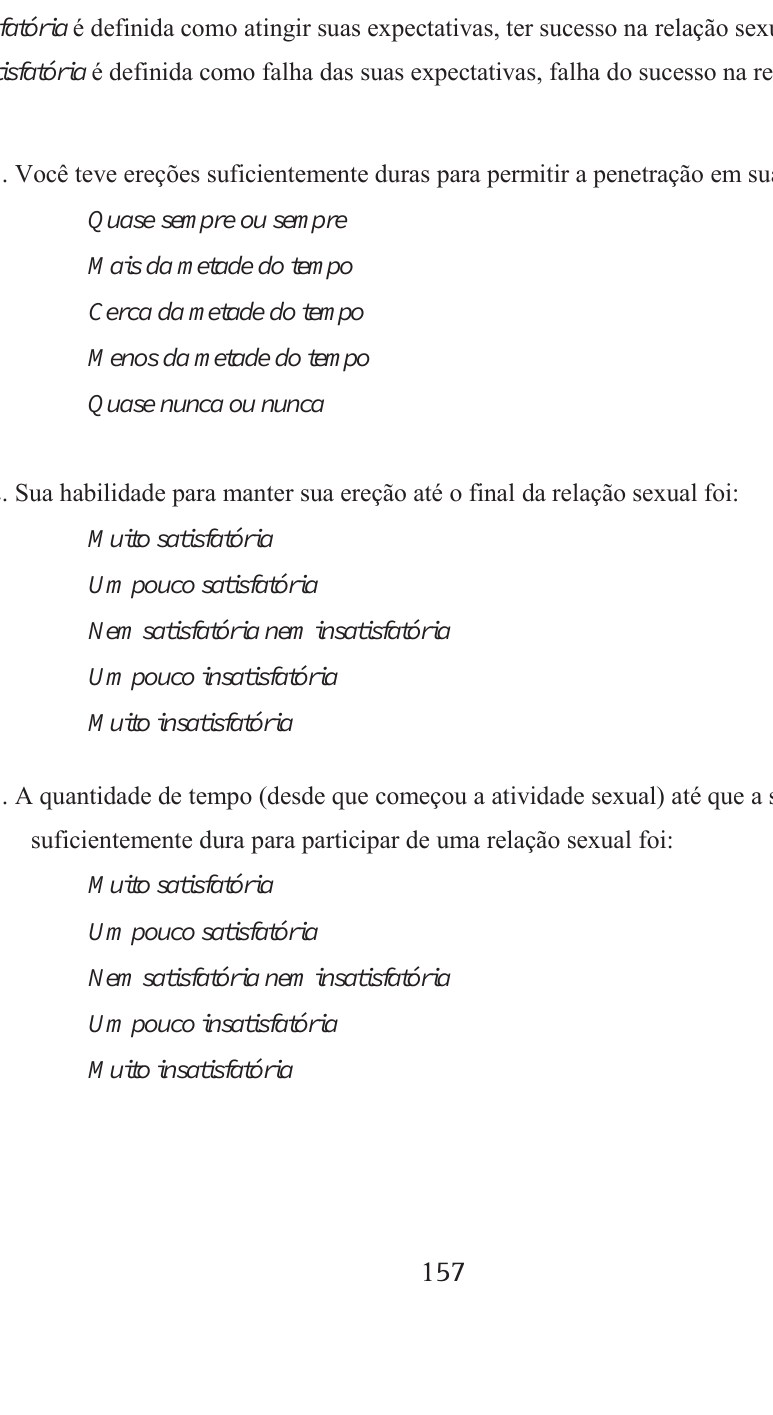
Questionário de Qualidade da Ereção